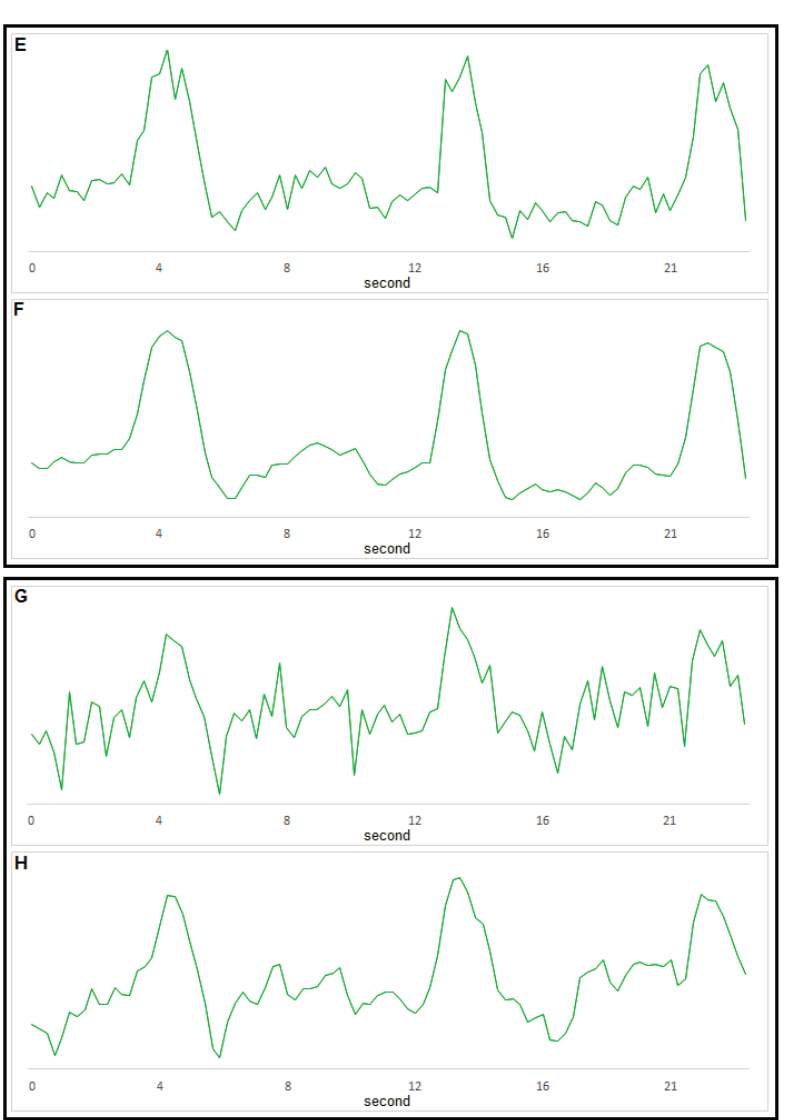
Figure 6. Extraction of spatial and temporal information from MP time series using our analytical approach. ( A ) Single image from a MP time series. Cell membranes were loaded with the membrane potential probe VF. The resolution was 256 × 128 pixels @ 4 fps; ( B ) the average image emphasizes cell outlines. The image was averaged over 720 frames; ( C ) visualization of MP change before onset of MP deflection. hFreqDiffFiltered is shown in green and meanImg in gray; ( D ) visualization of MP change (green) during MP deflection. Colors as on panel C; ( E ) the MP signal from the larger area enclosed by the rectangle in panels A and B before denoising; ( F ) the MP signal from the respective ROI after denoising; ( G ) the MP signal from the smaller area enclosed by the rectangle in panels A and B before denoising; and ( H ) the MP signal from the respective ROI after denoising. The noise was removed using a Gauss convolution kernel 3 × 3 and a standard deviation of 1 for the spatial domain and moving average filter with a window of length two. The signal has been amplified by a factor of